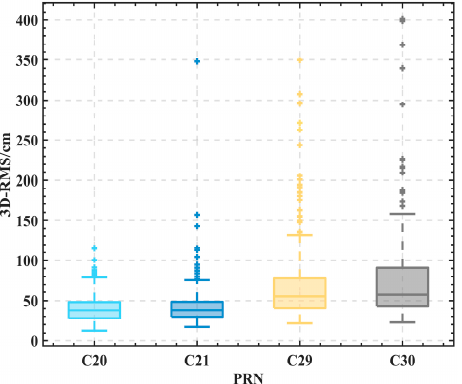
Figure 6. Box-plots for the four BDS-3 satellites under the 9-day solution.